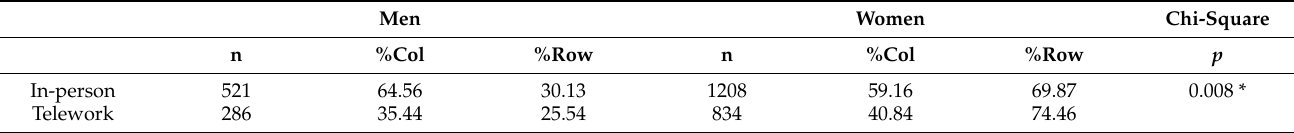
Table 1. Relationship between telework and gender.